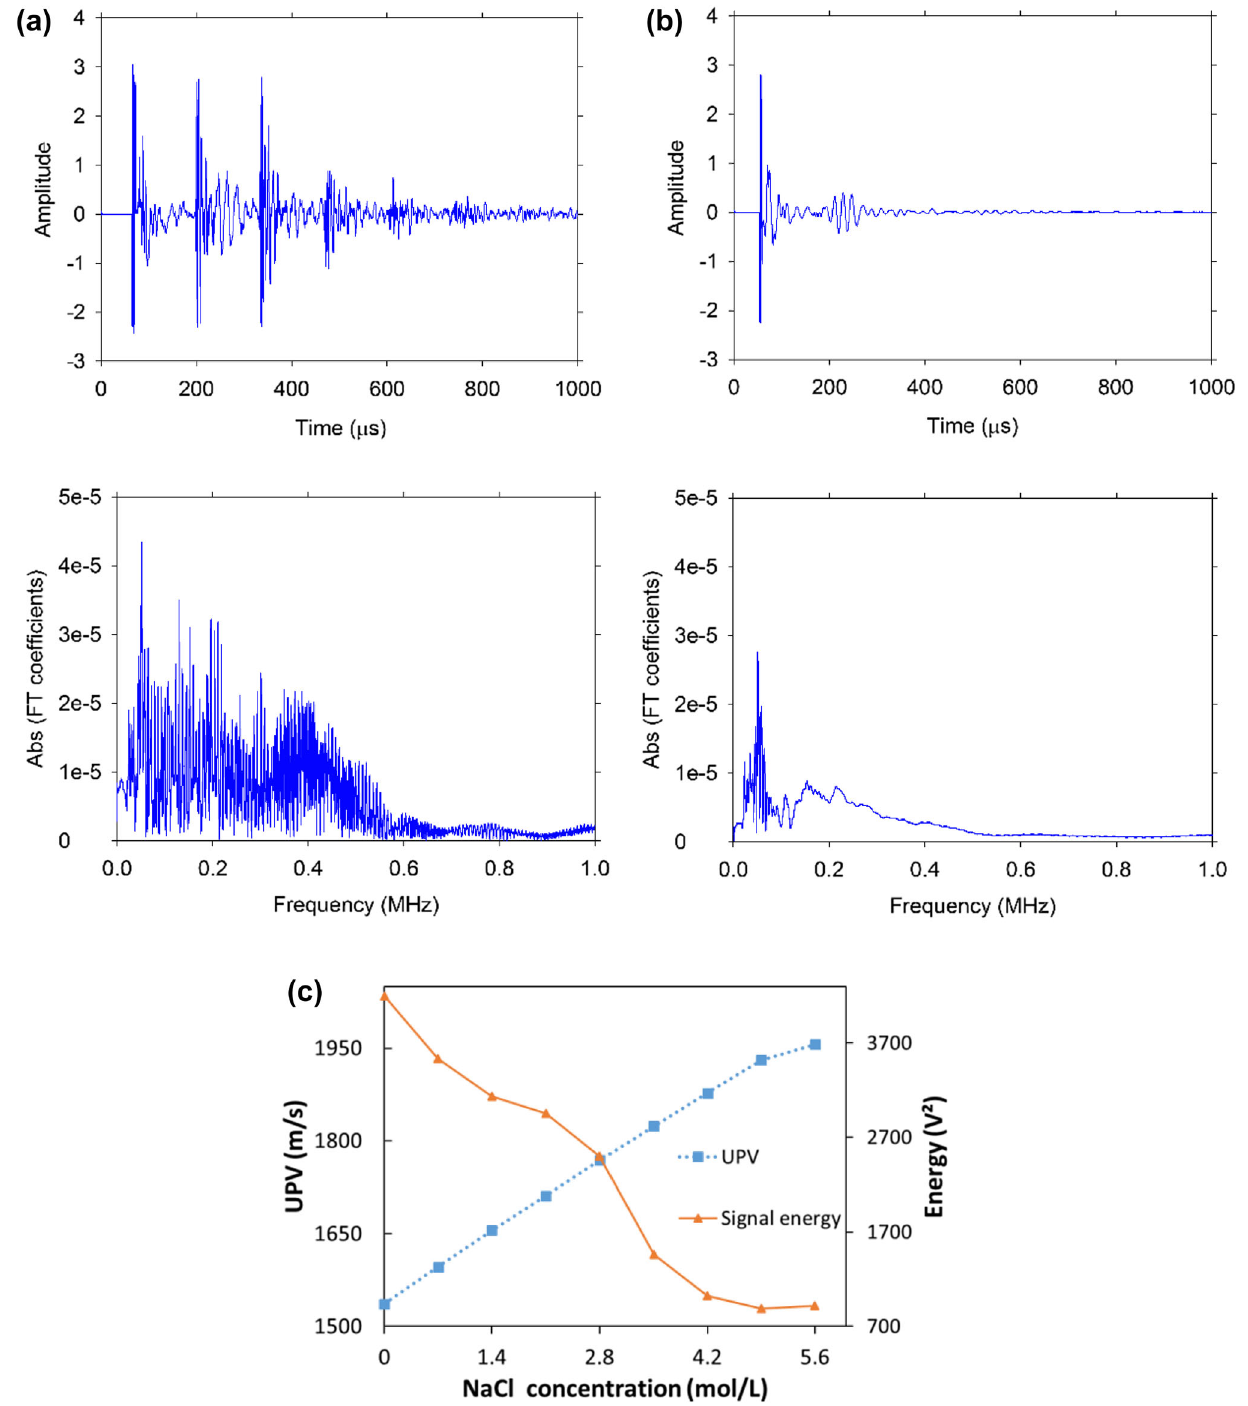
Fig. 6 Time and frequency domain ultrasonic responses of NaCl solutions at concentrations of a 0 mol/L, b 5.6 mol/L, and c Energies and UPVs of nine different NaCl